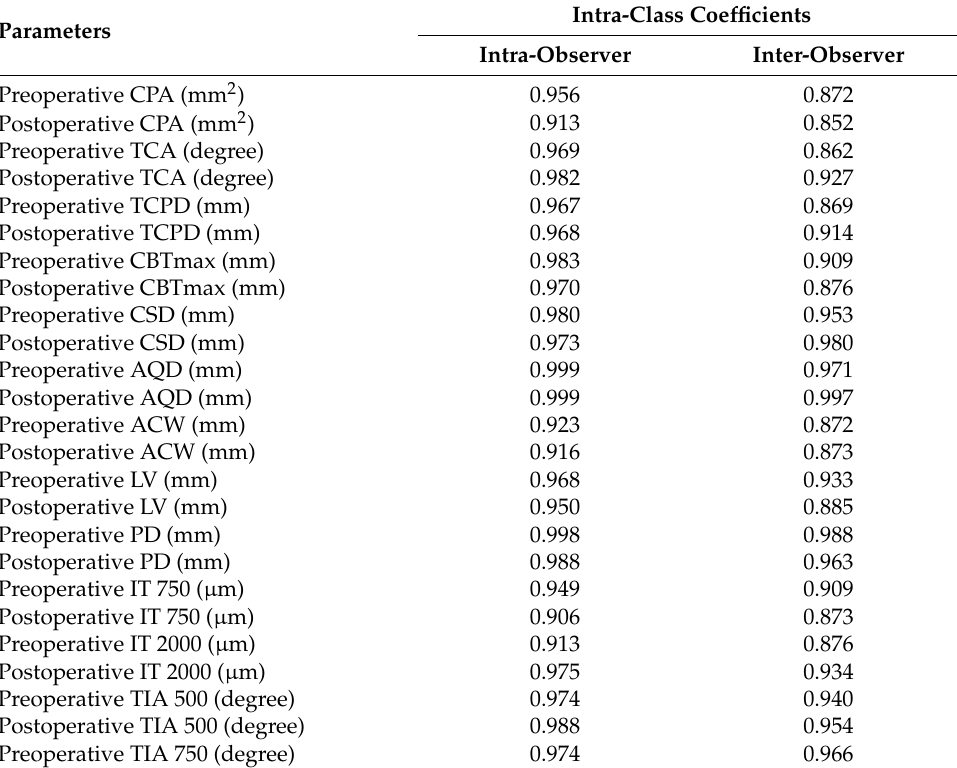
Table 3. Intra-observer and inter-observer intra-class coefficients of the preoperative and postopera- tive